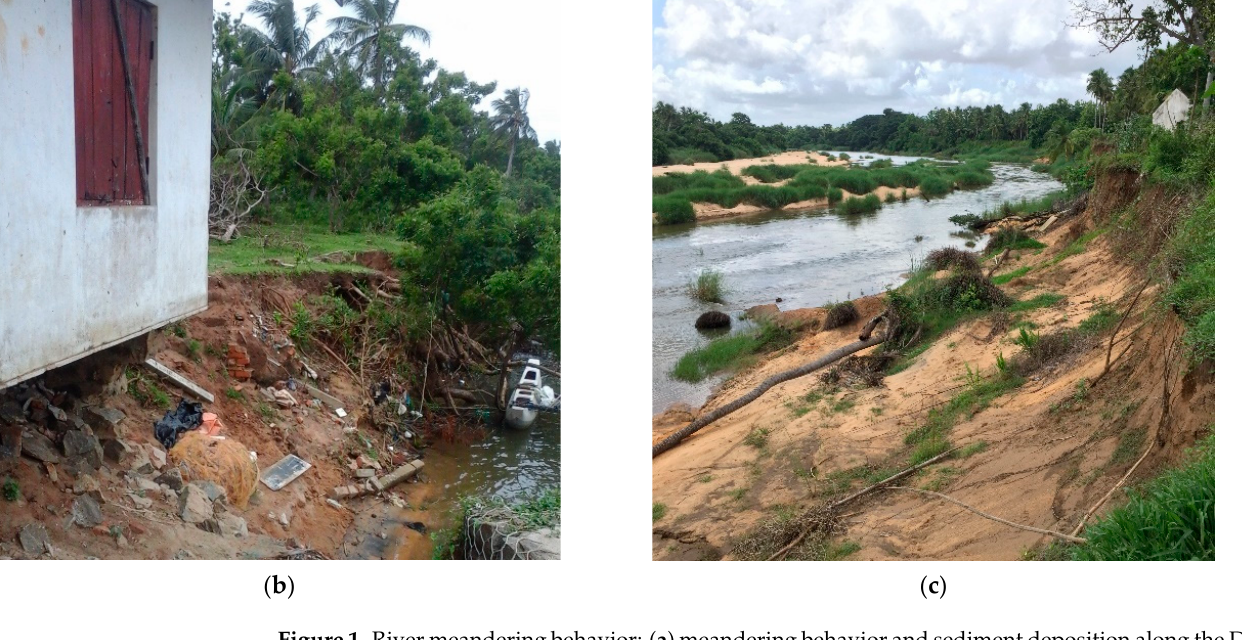
Figure 1. River meandering behavior: ( a ) meandering behavior and sediment deposition along the Deduru Oya (source: Google maps); ( b ) eroded riverbanks and damaged houses (photo credit—D.C.H); ( c ) meandering bend (photo credit—D.C.H).